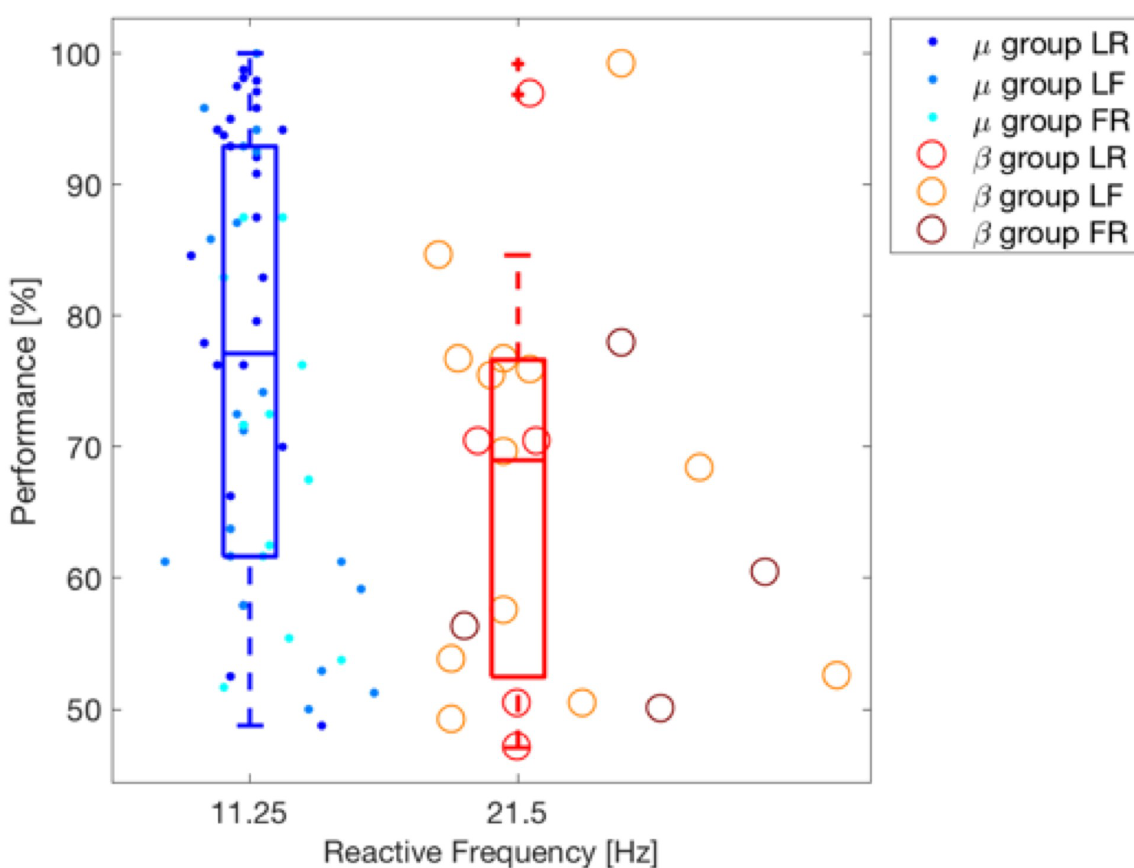
Fig 7. Clustering of users depending on their SMR reactive frequency band. K-mean clustering is applied on the values of the reactive frequency bands. One dot per subject, dots or circles depending on the cluster the user belongs to. Different tonalities indicate different class- combination for each of the two clusters. Feedback performance is shown on the y-axis. The box plots corresponding to the performance information for each cluster are also shown.